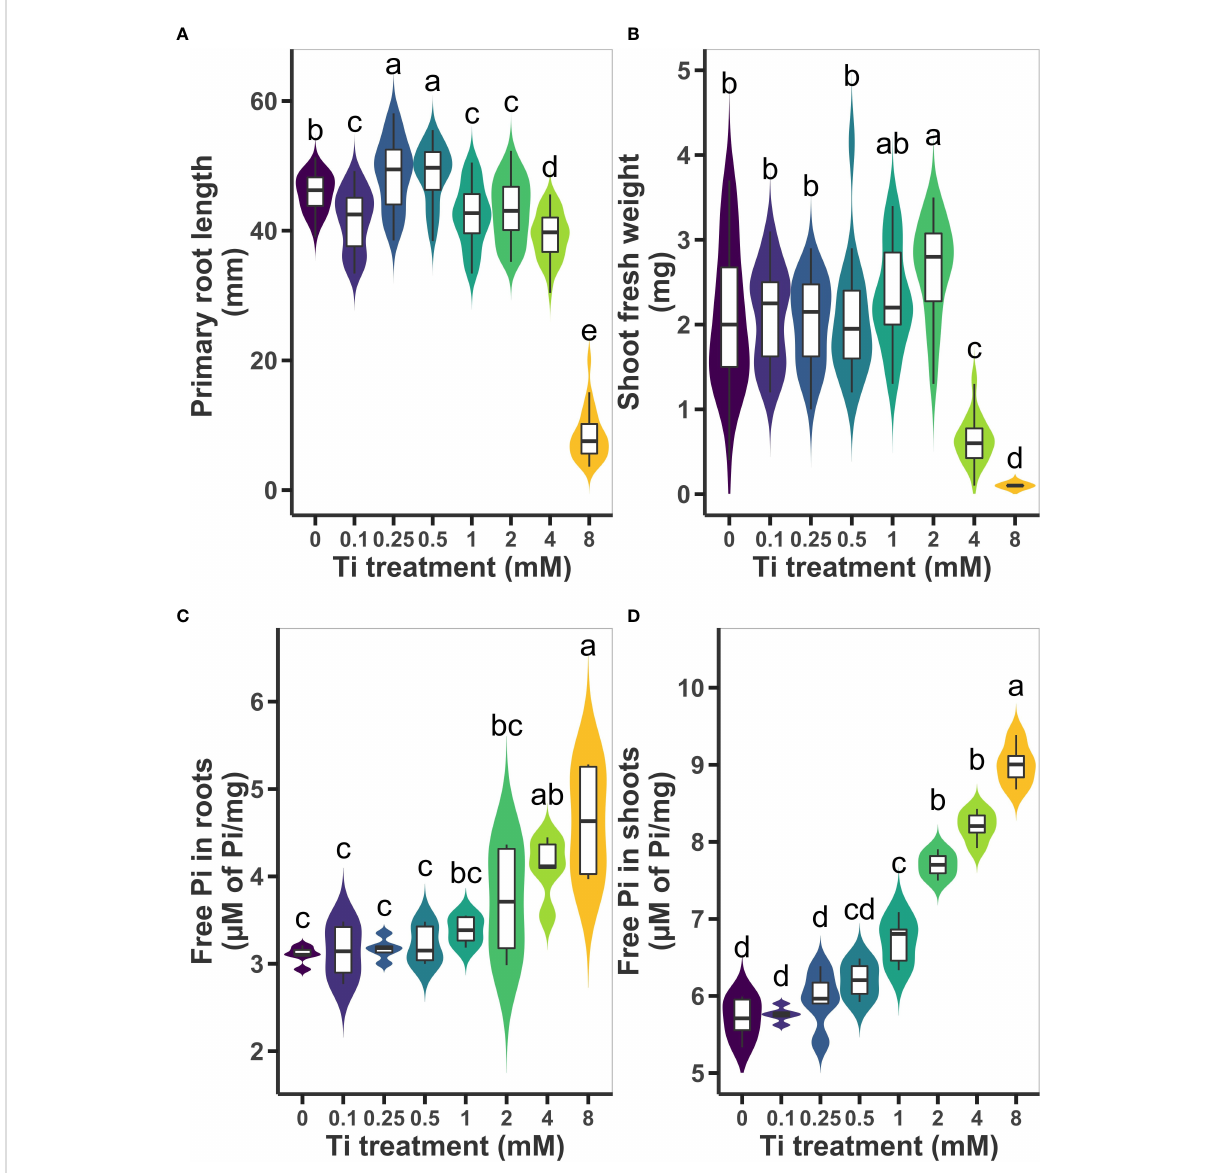
FIGURE 1 Effect of Titanium (Ti) on Arabidopsis growth and inorganic phosphate (Pi) content. (A) Primary root length and (B) shoot fresh weight were determined ten days after treatment with 0.2, 0.25, 0.5, 1, 2, 4, and 8 mM Ti. Concentration of free Pi was also determined in roots (C) and shoots (D) from experiments in (A, B) No added Ti (0) was used as control treatment. Different letters indicate statistically signi fi cant differences according to Tukey ’ s signi fi cance test (p<